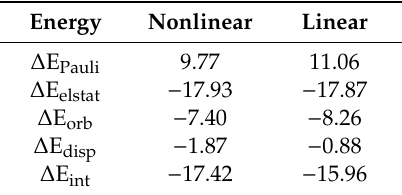
Table 2. The BP86 / TZ2P interaction energy for two configurations of the BF 4 − ... HCN complex, the terms resulting from the decomposition are given (all energies in kcal / mol) according to Equation